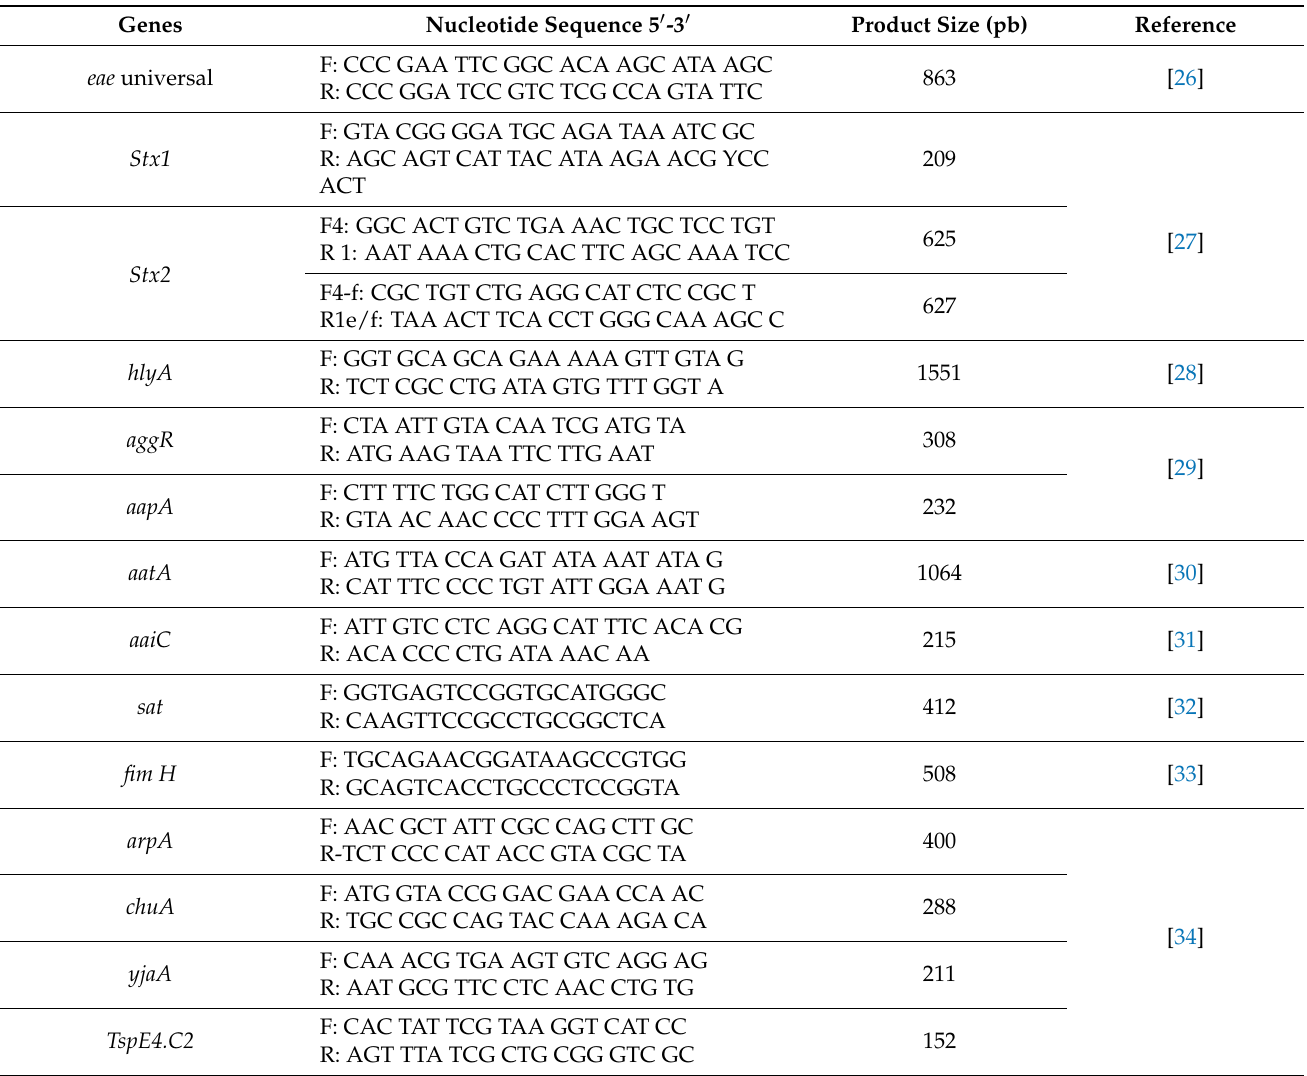
Table 1. Primers used to identify virulence genes of DEC groups and phylogenetic groups. Genes Nucleotide Sequence 5 (cid:48) -3 (cid:48) Product Size (pb)